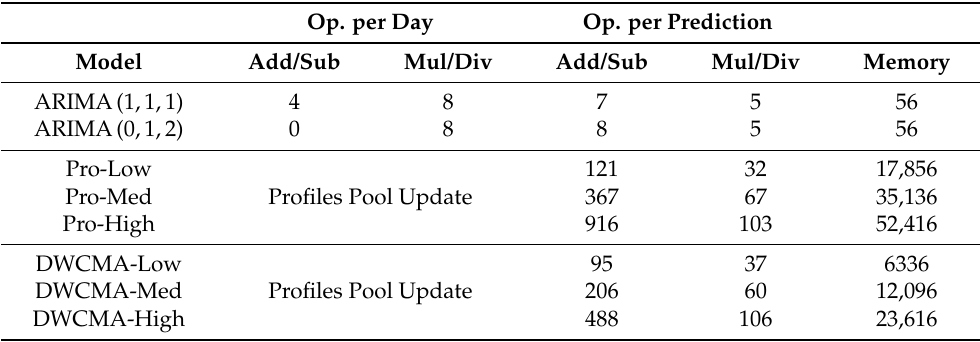
Table 3. Number of operations and memory overhead (in bytes). Op. per